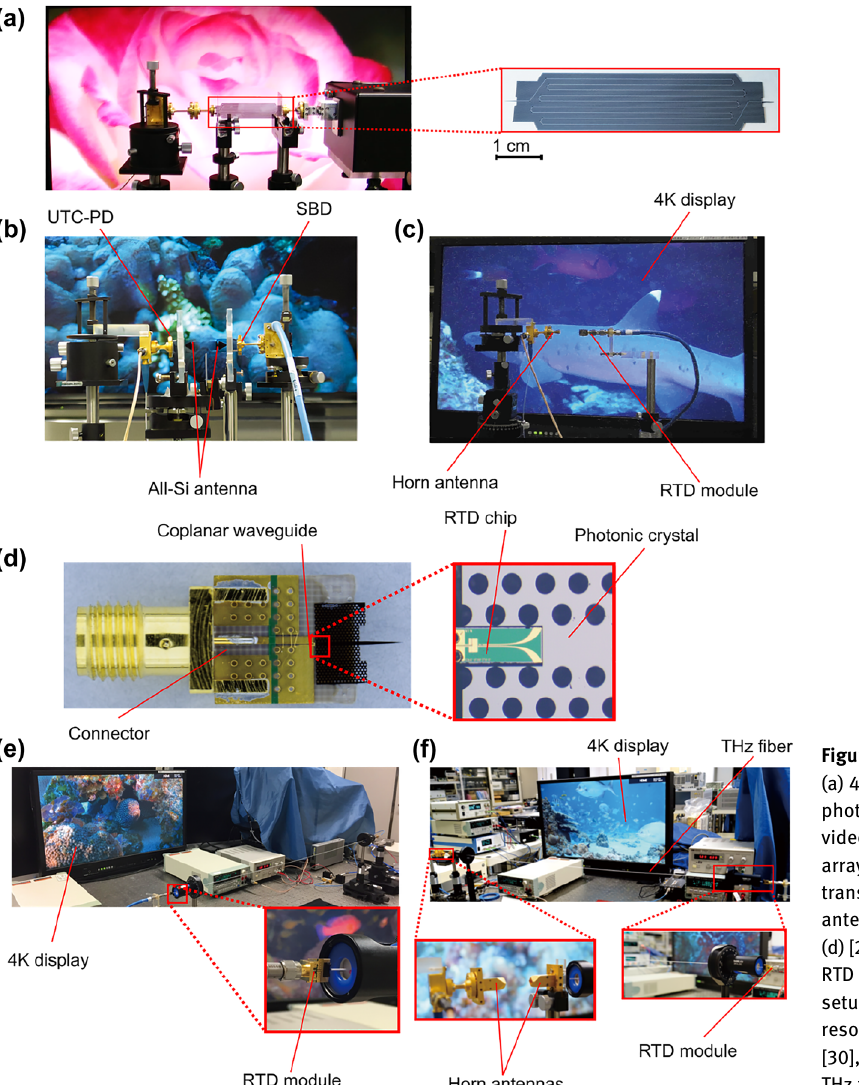
Figure 5: THz communication applications, (a) 4K video transmission over 50 cm-long photonic crystal waveguide [13], (b) 4K video transmission with dielectric rod array antennas [105], (c) wireless transmission of 4K video using a horn antenna and an RTD module shown in (d) [29],(d) RTD integrated modulewith the RTD chip as inset [30], (e) experimental setup showing the transmission of 4K resolution video over THz fi ber wired link [30], (f) 4K resolution transmission over THz fi ber wireless link